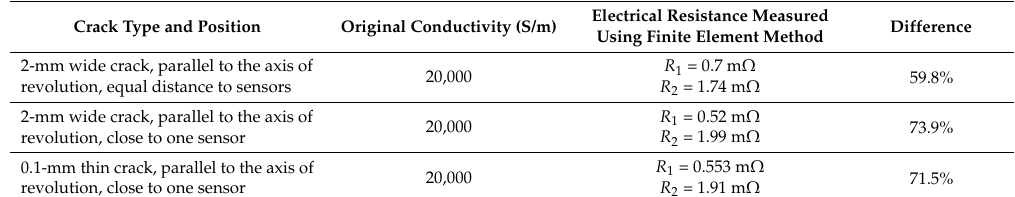
Table 4. Difference for two contiguous resistances for a sample containing a crack parallel to the axis of rotation, calculated using the FEM method.